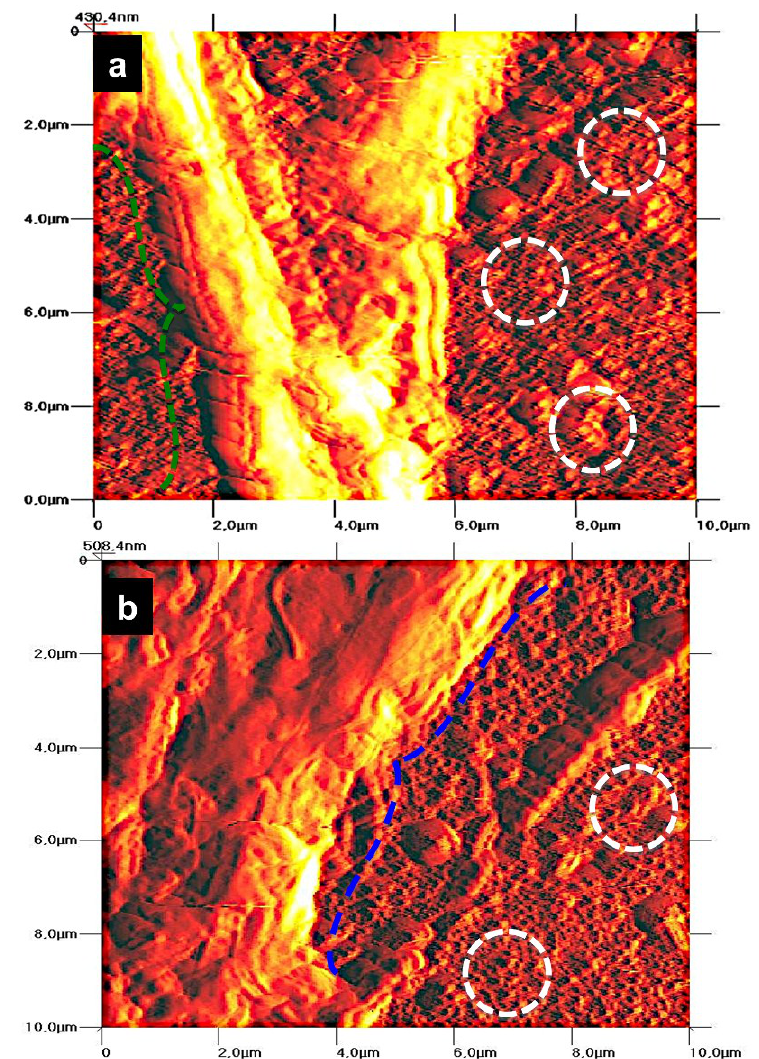
Figure 7. AFM micrographs for PPO and PCC cells at Day 3 of cell growth on anodized Ti6Al4V alloy. ( a ) PPO; ( b ) PCC. (The green dashed arrow indicates cellular filopodia; the blue dashed arrow indicates monolayer-like morphology; circles represent the NTs’